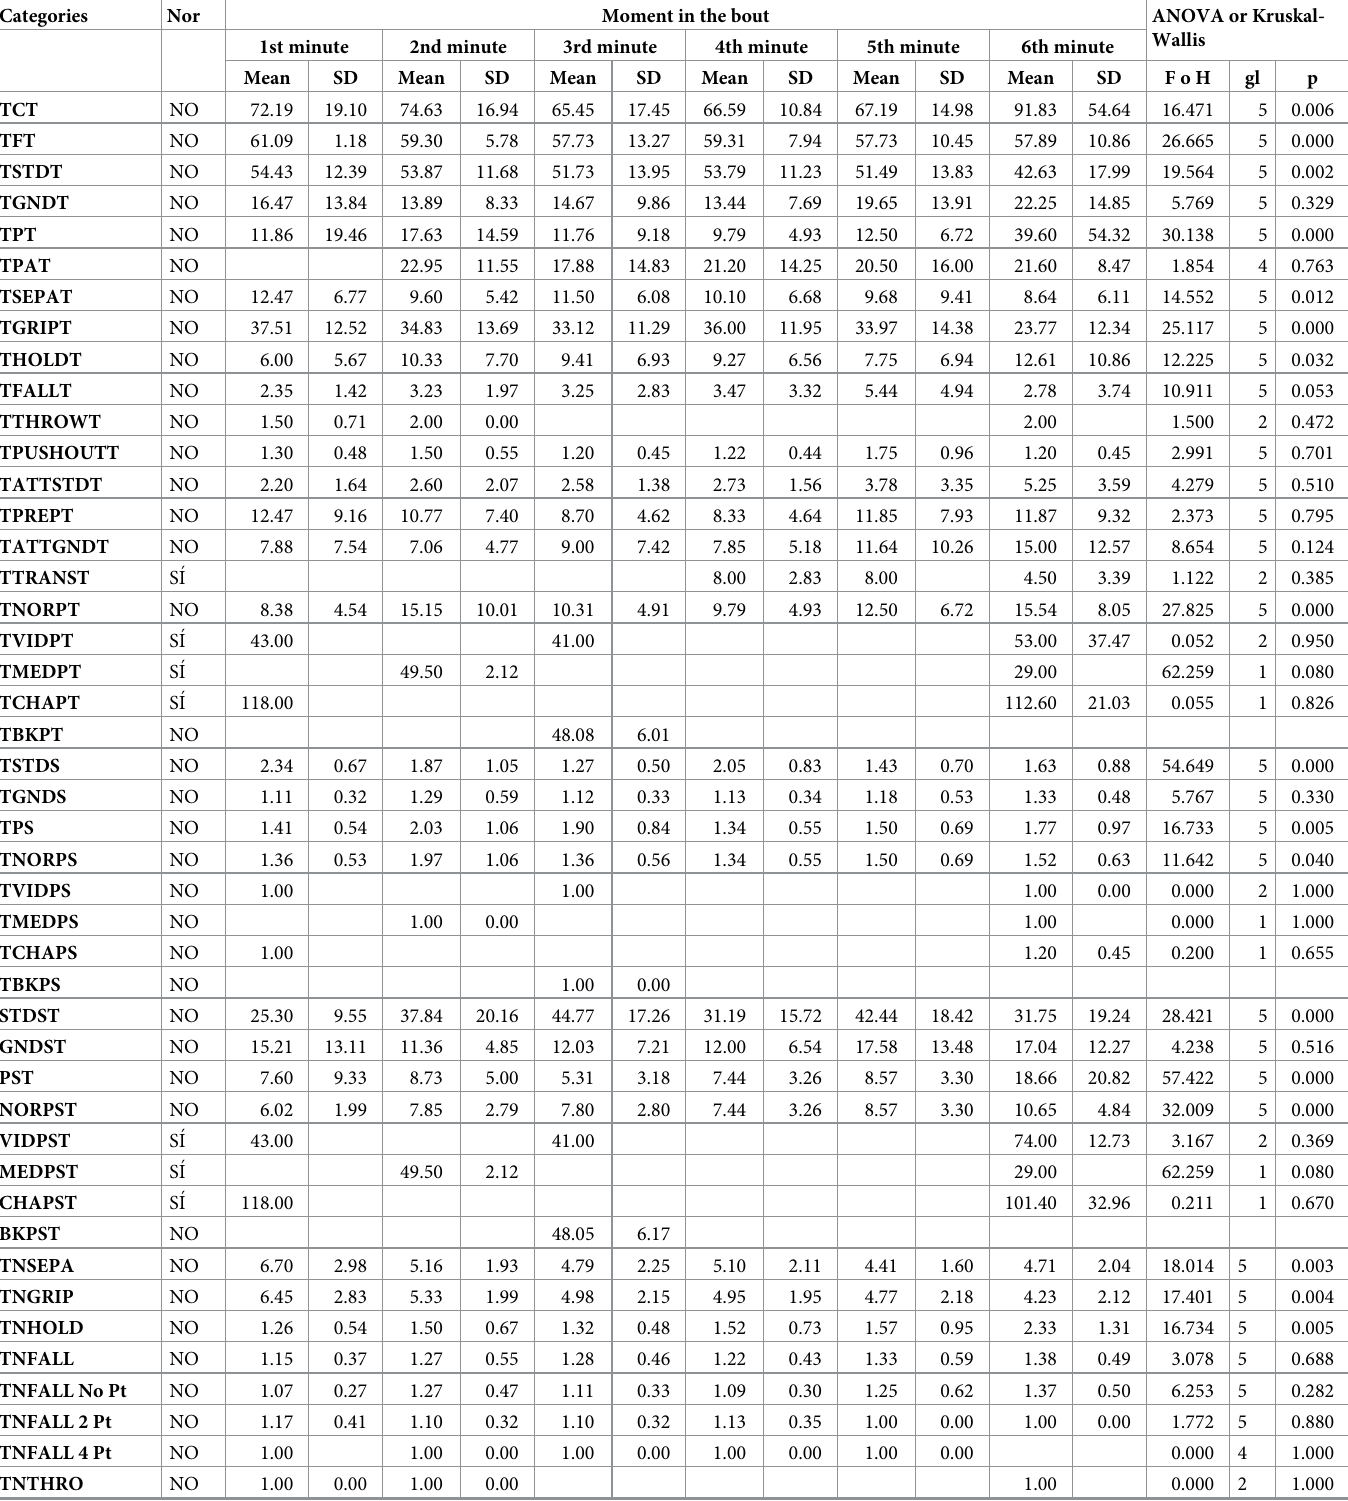
Table 5. Sequential and temporal parameters in the different minutes of the bout in the 86 kg category.